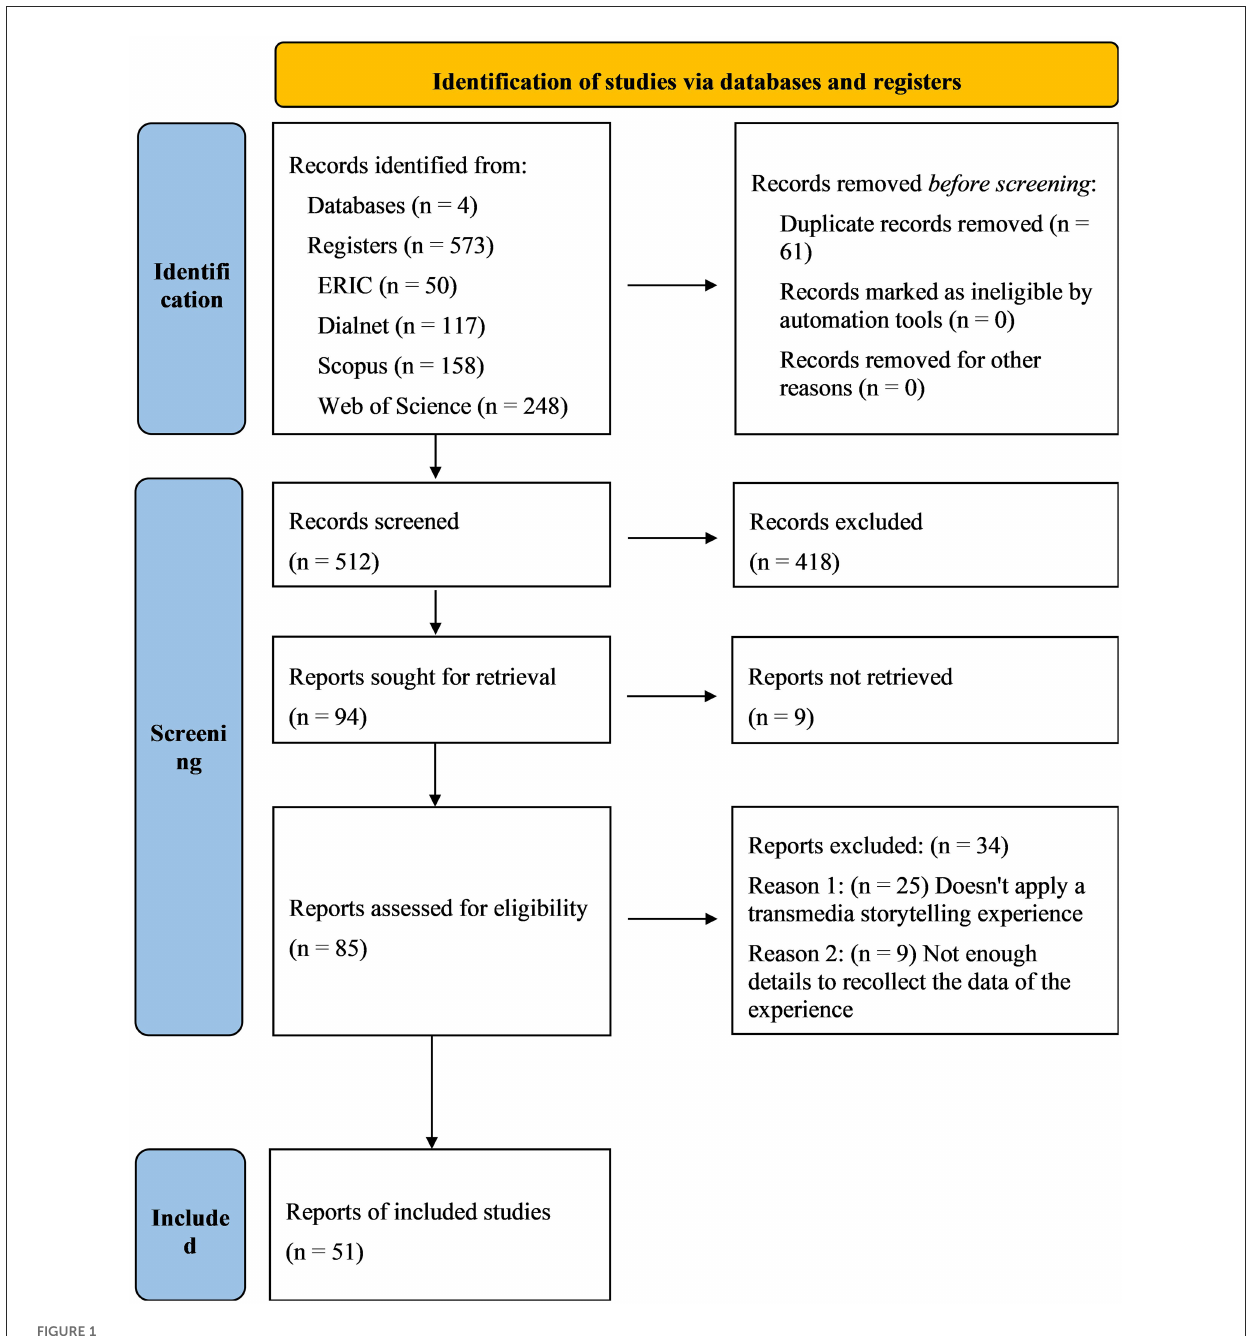
FIGURE1 Identification of studies via databases and registers using PRISMA 2020 (Page et al., 2021). For more information, visit: http://www.prisma-statement.